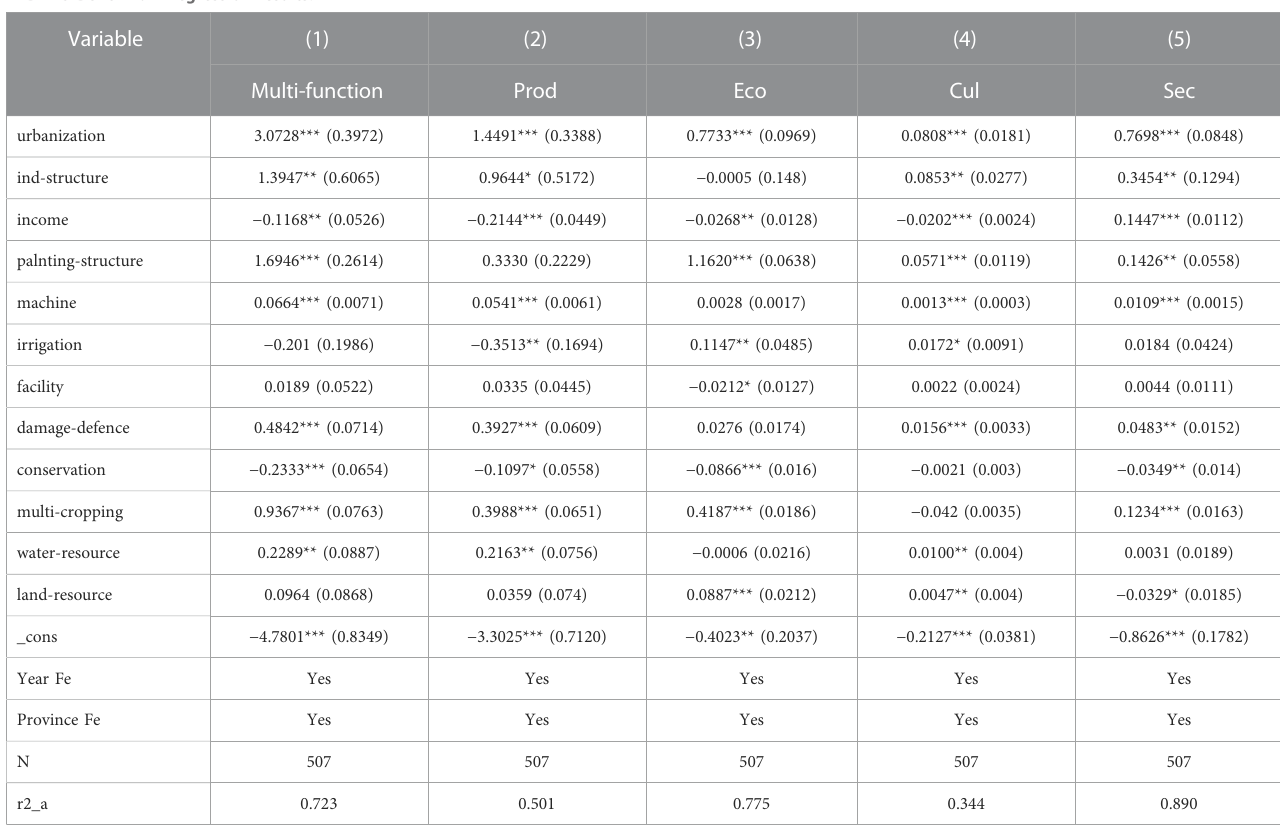
TABLE 3 Benchmark regression